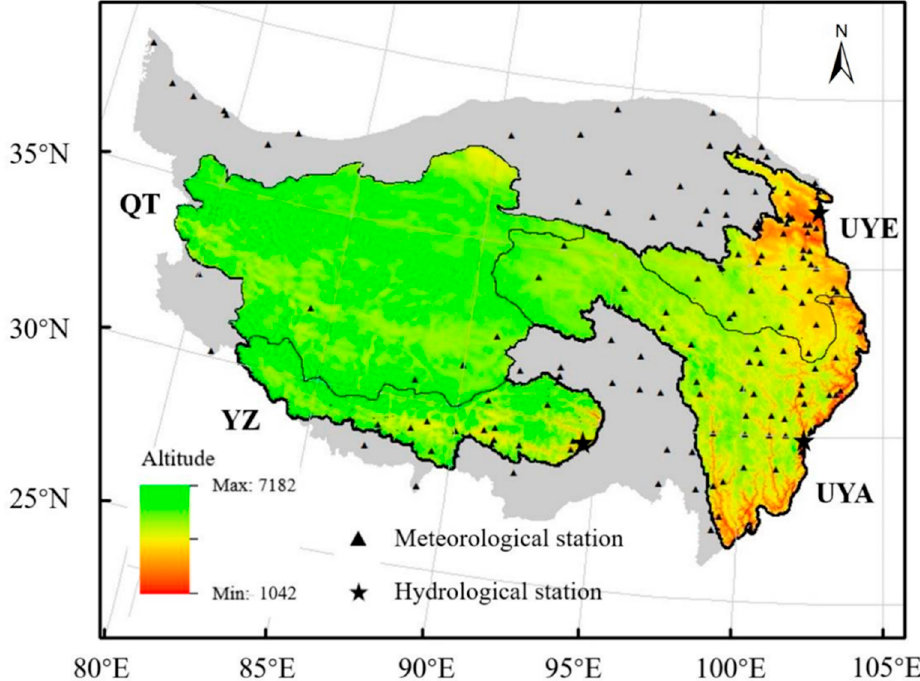
Figure 1. Map of the study area. QT denotes the Qiangtang Plateau (68.26 × 10 4 km 2 ). UYA denotes the upper Yangtze River (69.47 × 10 4 km 2 ). UYE denotes the upper Yellow River (12.20 × 10 4 km 2 ). YZ denotes the Yarlung Zangbo River (18.93 × 10 4 km 2 ). The data for the National Meteorological Stations were updated to 2012.